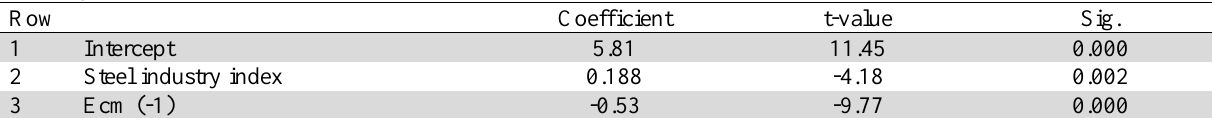
The summary of the results of ADRL Correction-Error on the effects of subsidy removal on Steel